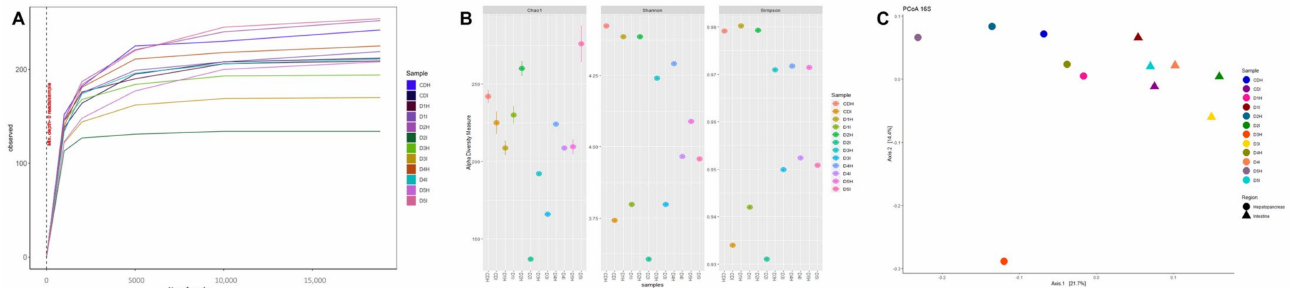
Figure 3. 16S rRNA gene sequencing of intestines and hepatopancreas from shrimp fed control diet and 50% fishmeal replacement diets. ( A ) Rarefaction curve, ( B ) Alpha diversity, and ( C ) Microbiota structure visualized using principal coordinate analysis (PCoA) plots. Abbreviations: Intestine (I) and hepatopancreas (H). CD (200 g/Kg FM), D1 (0.13% DL-MET), D2 (0.06% MET-MET), D3 (0.19% MET-MET), D4 (0.13% DL-MET plus 0.10% B. amyloliquefaciens CECT 5940) and D5 (0.06% MET-MET plus 0.10% B. amyloliquefaciens CECT 5940).